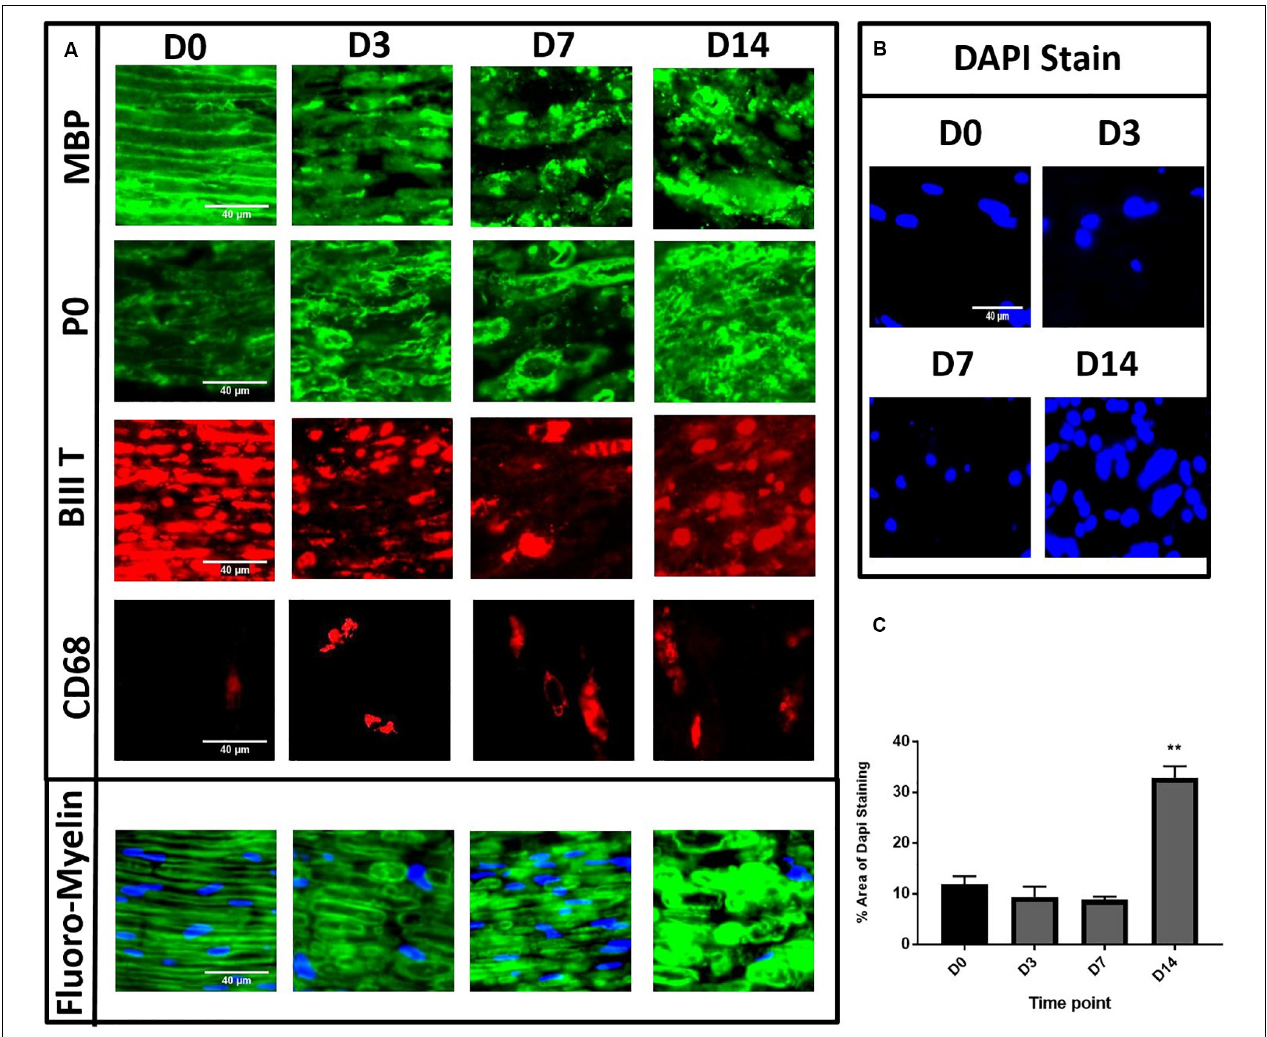
FIGURE 2 | Immunohistochemistry of in vitro model of degeneration showing degenerative changes to both myelin lipids, myelin proteins and axons. Panel (A) showed MBP/ β IIIT/P0 staining with evident degeneration at D14 and Fluoro-Myelin staining with lipid degeneration. (D0) Compact homogenous organised myelin and axons resembling normal nerve. (D3) Loosening and disorganisation of myelin with multiple discontinuity. (D7) Continued loosening and disorganisation with greater disruption of myelin structure. (D14) Consolidated mass with loss of architecture. CD68 staining with gradual increase in numbers of cells after degeneration induction. (B,C) Gradual increase of % area of DAPI staining in desheathed explants at different time points showing significant increase at D14. (D0 is control.) (** P < 0.001) Scale bar for MBP, P0, β IIIT, Fluoro-Myelin and DAPI is 40 µ m. Scale bar for CD68 is 200 µ